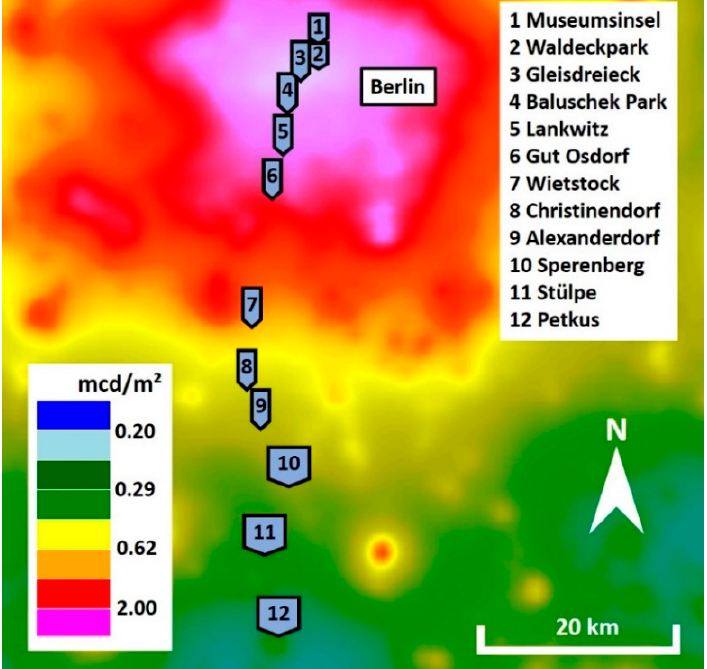
Figure 1. Map of the transect stops around the city of Berlin, Germany using modeled skyglow data from the world atlas of artificial night sky brightness [23] for the Berlin area (source: lightpollutionmap.info by Jurij Stare).